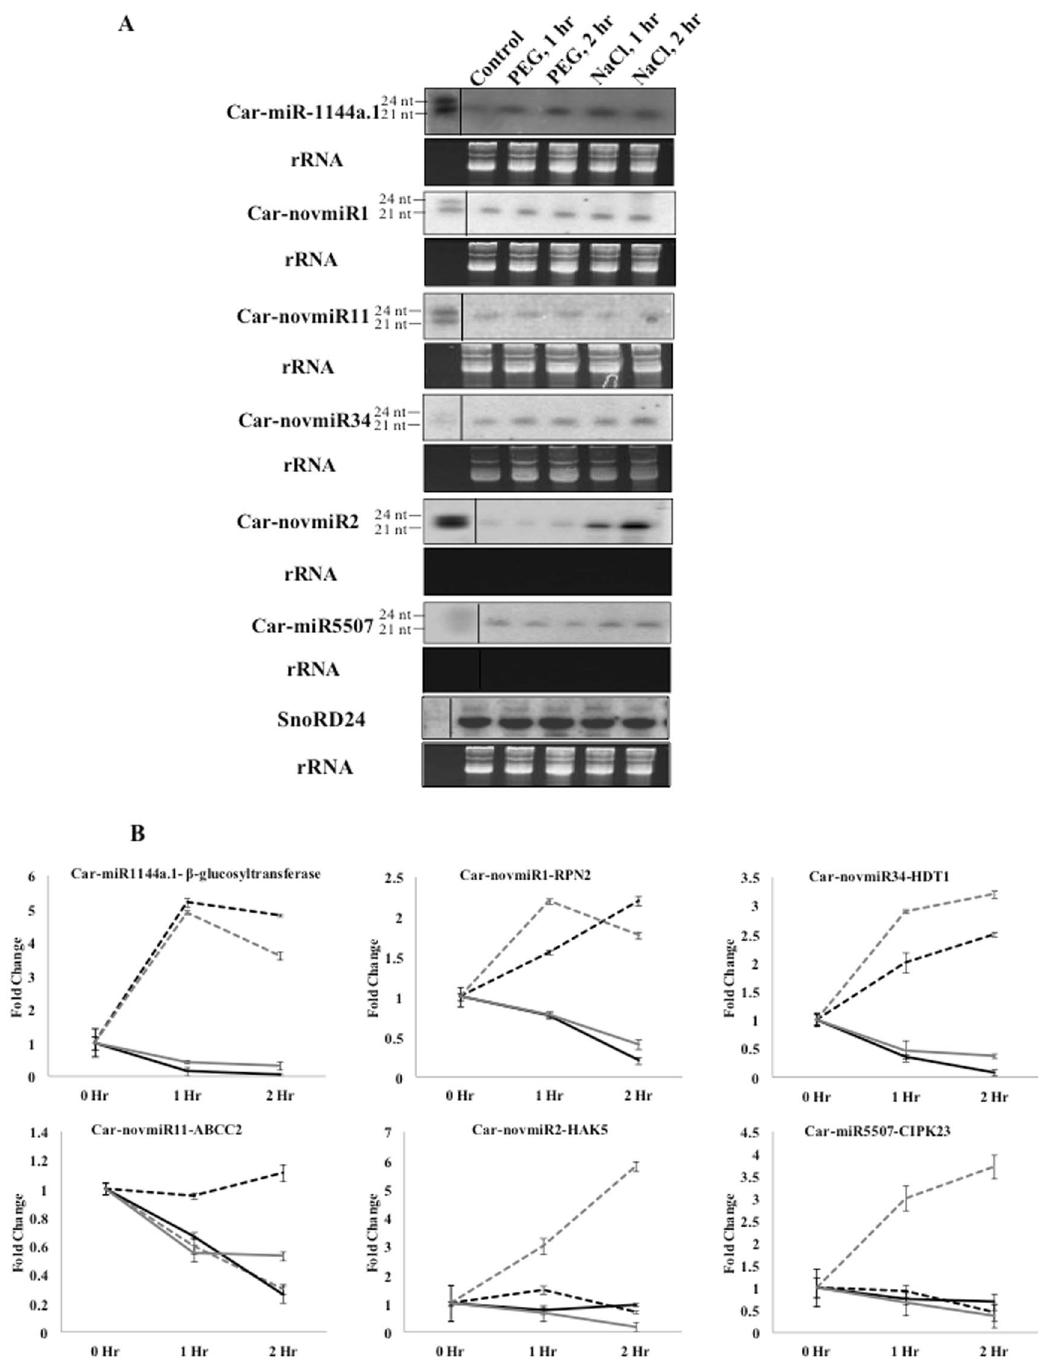
Figure 4. Expression patterns of selected miRNAs obtained by high throughput sequencing and their target genes. ( A ) Northern blot was performed to analyse expression levels of miRNAs at 2 mm region of chickpea root apex after 1 hr and 2 hrs of PEG and salt treatments. 15 µ g of enriched small RNA from control and treated samples was loaded on denaturing (7 M urea) polyacrylamide (15%) gel. Radiolabeled antisense probes were used for hybridization. Ethidium bromide-stained small RNAs were shown for equal loading. SnoRD24 was used as control. Size markers (24 nt and 21 nt) were electrophoresed together with the experimental samples and separated before hybridization with marker-specific probes. ( B ) Expression pattern of the miRNAs shown in Fig. 6A and their predicted target genes in response to the same treatments as assessed by qRT-PCR. Standard deviations of three replicates were shown. CaEF1 α was used as internal control for normalization. Grey and black lines represent salt and water deficit stress treatments, respectively. While dotted and solid lines represent miRNA and target gene,